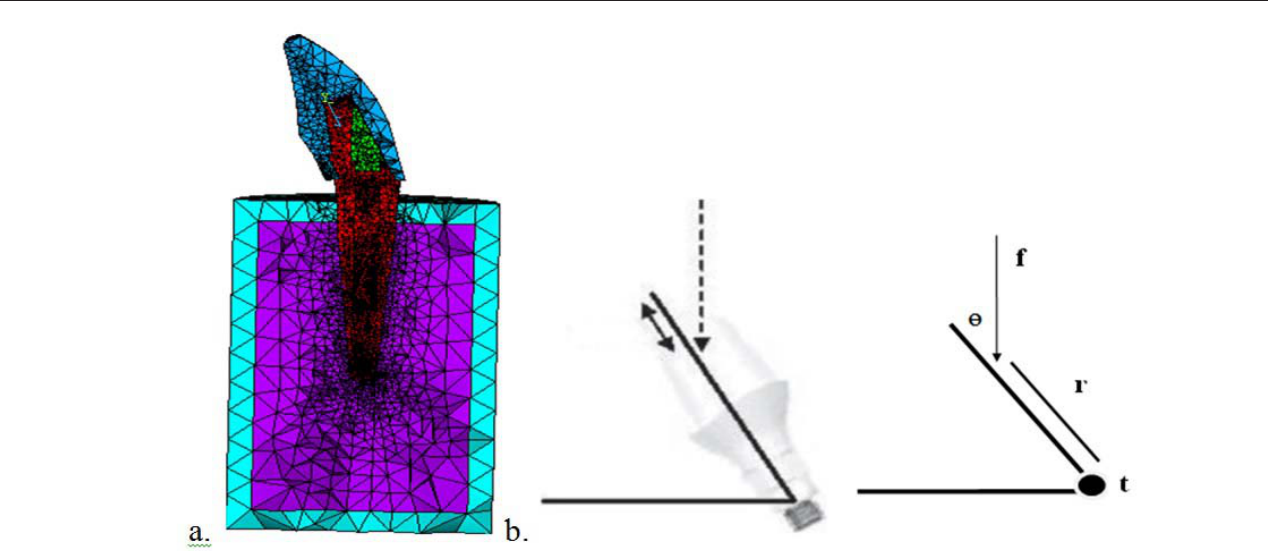
Fig. 2: (a) complete meshed model (b) schematic for load